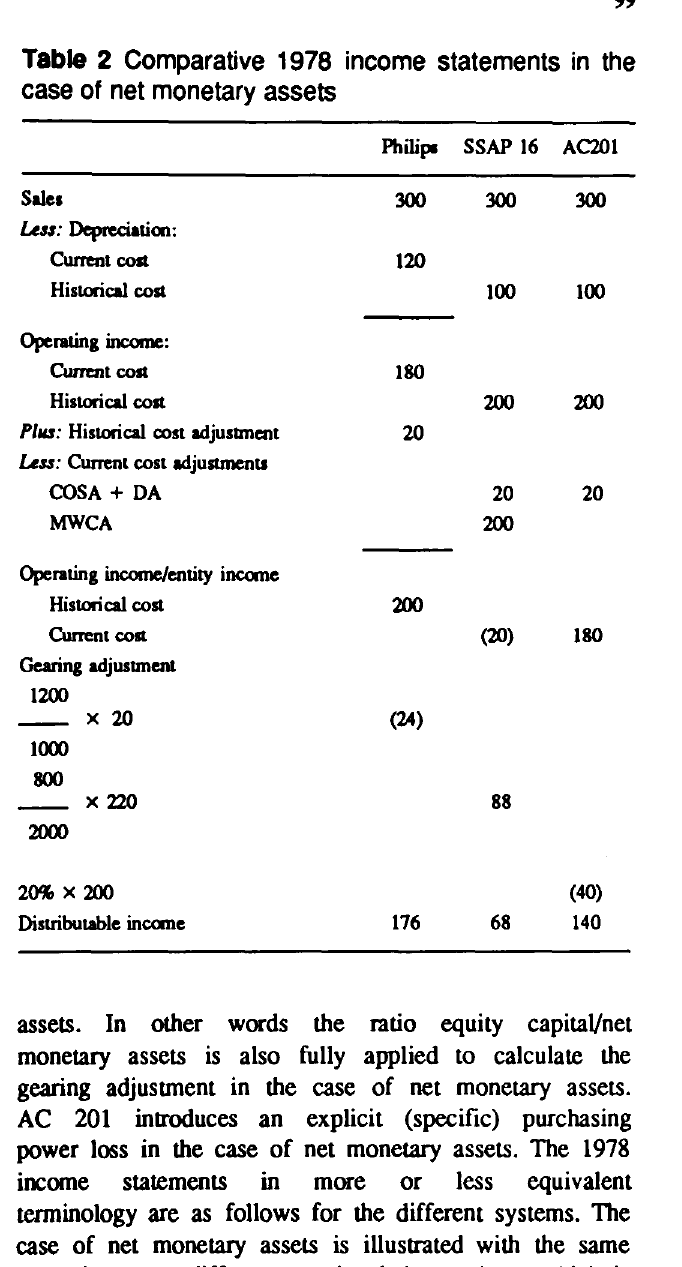
Table 2 Comparative 1978 income statements in the case of net monetary